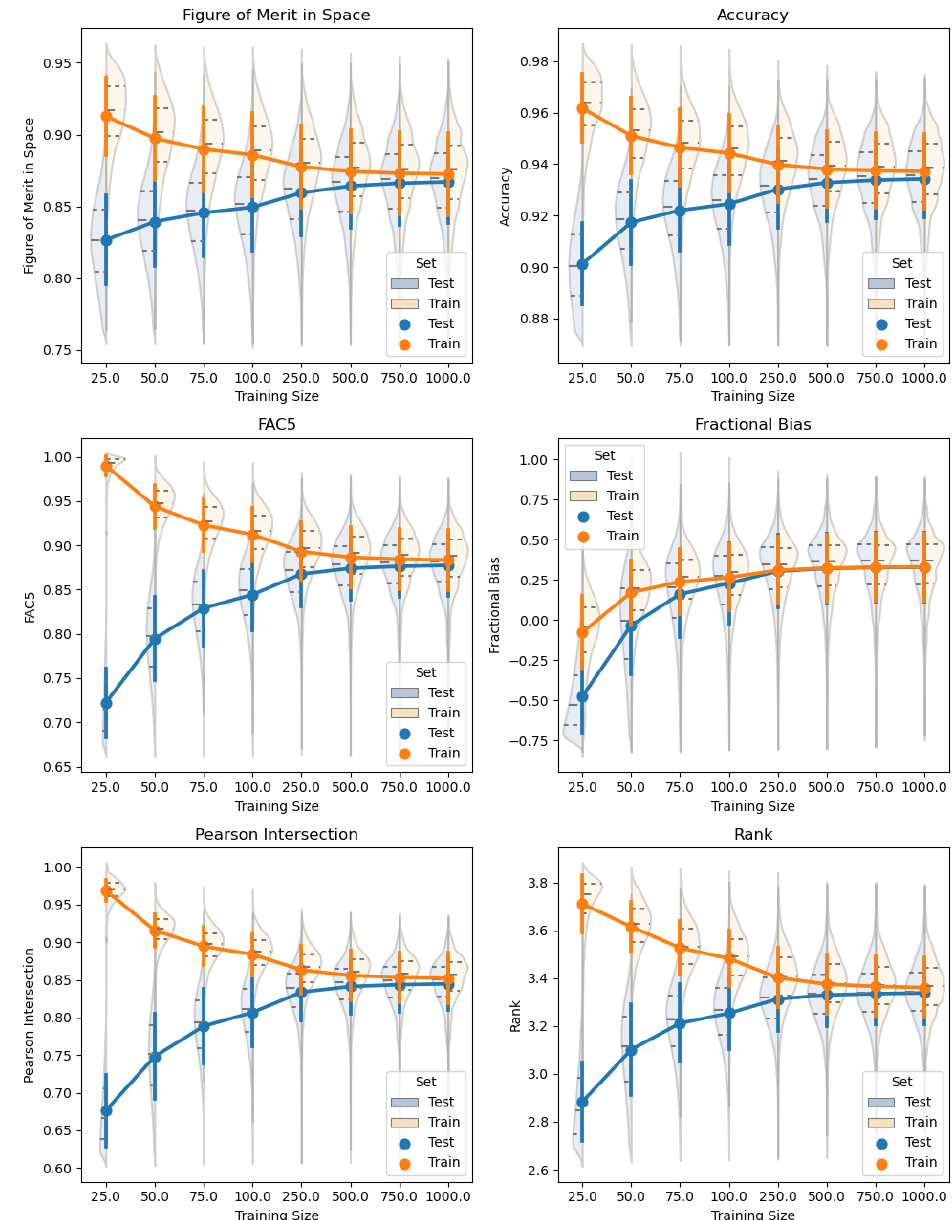
Figure 8. Spread of error metrics for all members for several different training sizes and 100 different random seeds for the surface release case. Training and test distributions are in blue and orange, respectively. A description of the metrics is provided in Section 5.2. Within the distributions, the dashed lines indicate the quartiles, the solid line is the mean, and the corresponding vertical bars are the standard